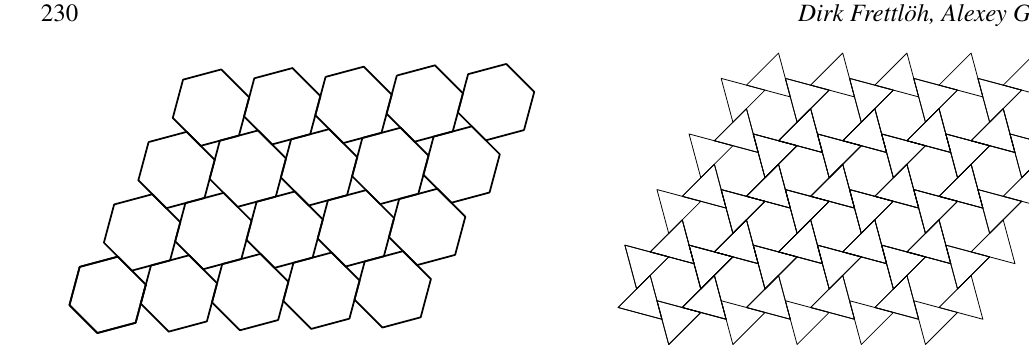
Fig. 50: Tiling with regular hexagon and regu- lar triangle. The edge of the hexagon is shorter (D).